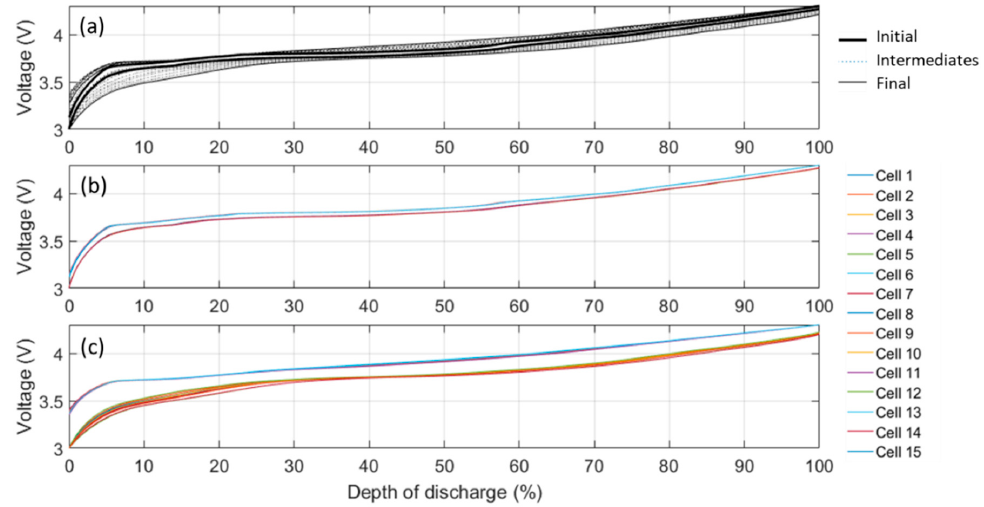
Figure 3. C/25 charge and discharge curves for ( a ) cell 1 upon cycling and associated changes; for the fifteen tested cells ( b ) at the initial stage and ( c ) after 1000 cycles.